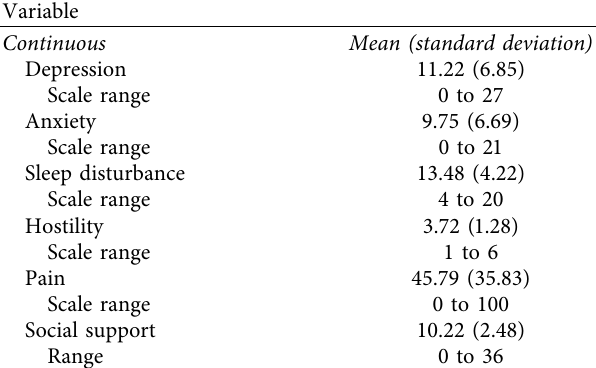
Table 2: Sample characteristics: biopsychosocial health